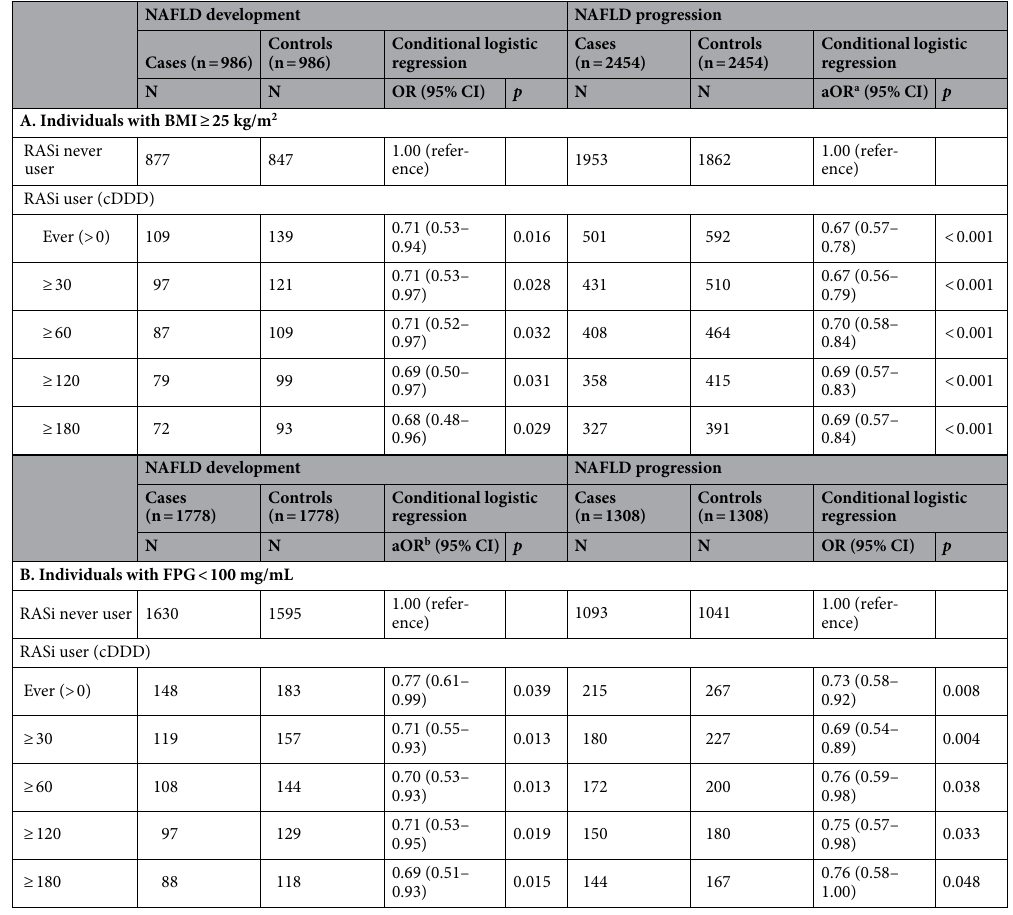
Table 5. Risk of NAFLD development and progression according to the RASi exposures in subgroups. a Adjusted for diabetes, α-glucosidase inhibitor, insulin, metformin, sulfonylurea, thiazolidinedione. b